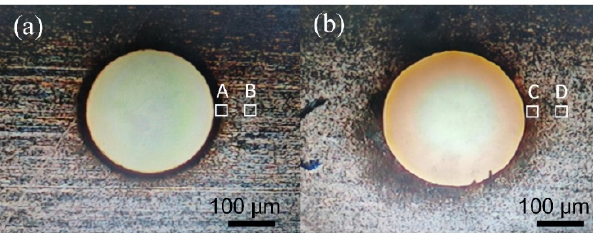
Figure 4. Inverted cone hole processed by femtosecond: ( a ) microhole entrance; ( b ) microhole exit. Table 1. Mass ratios of different elements in different regions of the microhole entrance and exit. Element